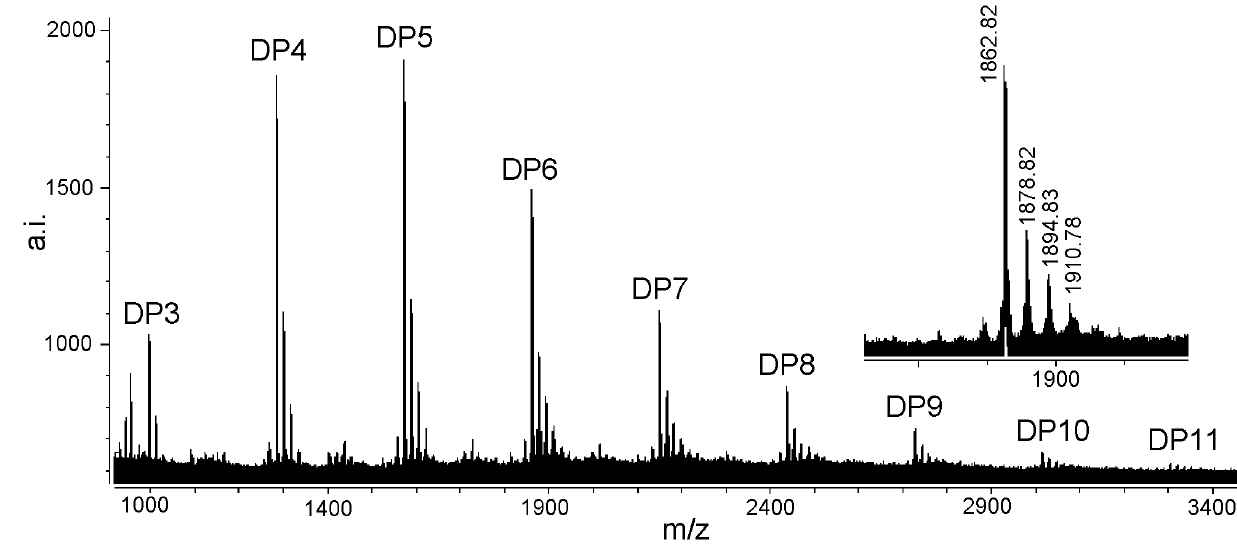
Figure 4. MALDI-TOF MS of condensed tannins from L . glaber